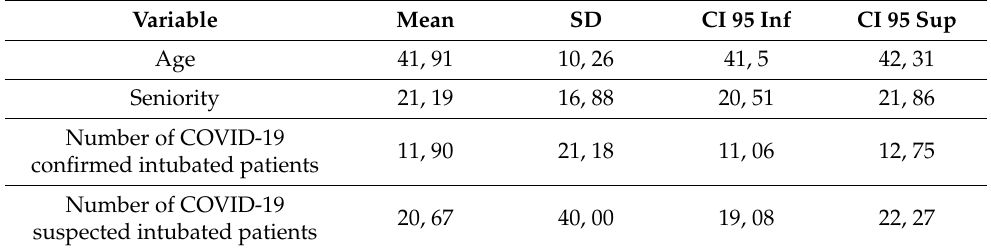
Table 1. Characteristics of the physicians who participated in the